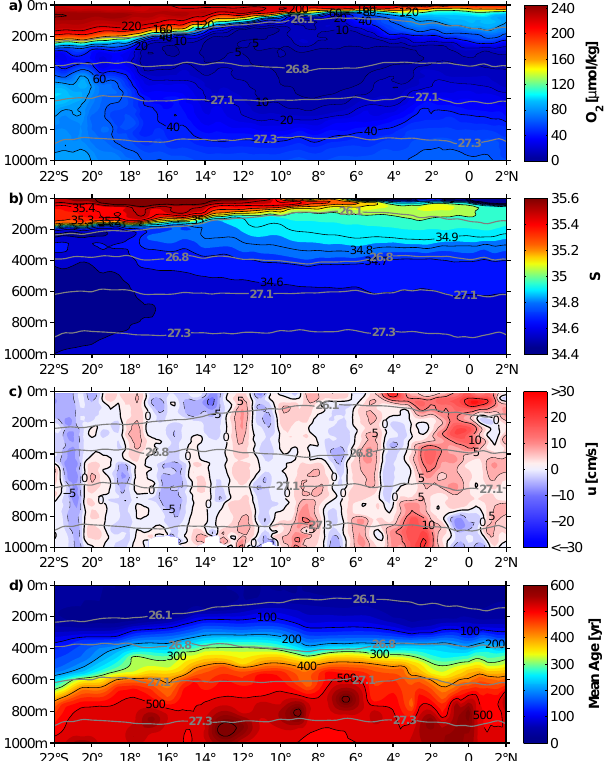
Figure 20. (a) Mean oxygen content, (b) salinity, (c) zonal veloc- ity (positive eastward), and (d) mean age as obtained from merid- ional ship sections taken on three Pacific surveys along ∼ 86 ◦ W from 1993 to 2012. Grey contours mark potential density (kgm − 3 ). The mean age is based solely on data from 1993. Eastward current bands, marked by reddish colours, are generally associated with el- evated oxygen